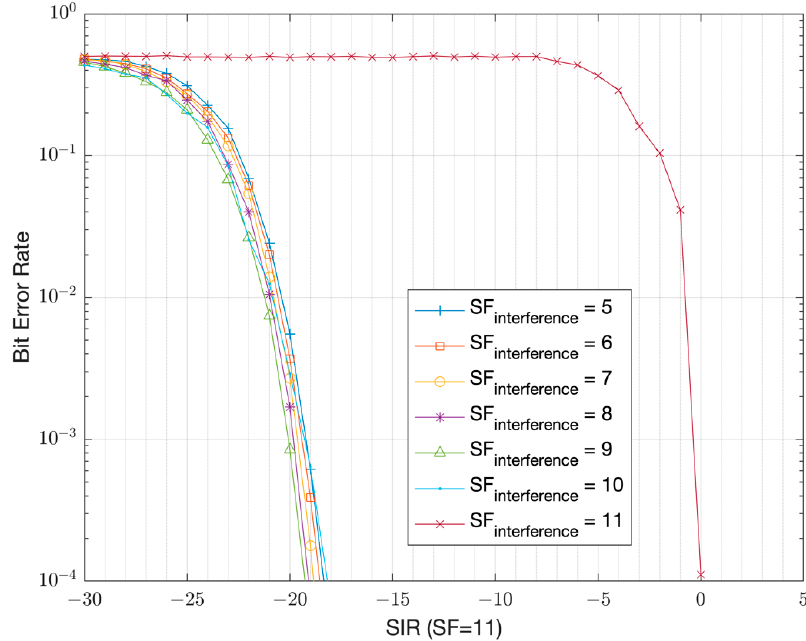
Figure 5. BER versus SIR without IQ inversion with SF-11 (500 kHz BW) [9].